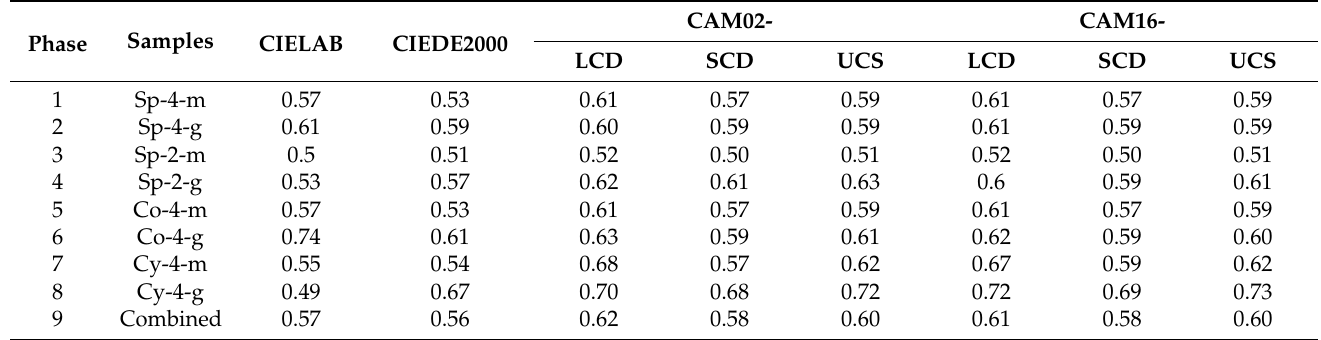
Table 7. Optimized values of the exponent b (power function) for the eight color-difference formulas and nine phases (see Table 1) in the visual experiments in